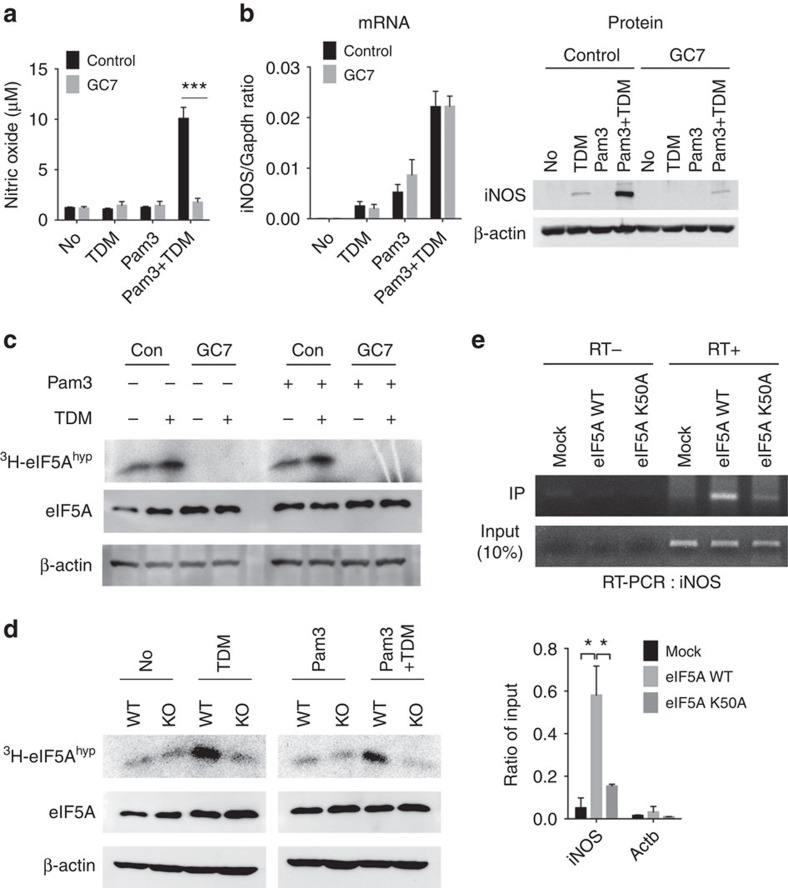
eIF5A hypusination is required for Mincle-mediated iNOS translation.(a,b) WT BMDMs were stimulated with TDM, Pam3 or co-stimulated with Pam3 and TDM in the presence of GC7 for 12 h. (a) Nitric oxide release in culture supernatants. (b) qRT-PCR (left) and immunoblot (right) analysis of iNOS mRNA or protein expression. (c) Fluorographic analysis of hypusinated eIF5A from WT BMDMs treated with Pam3, TDM or co-treated with Pam3 and TDM in the presence of control (con) or GC7. (d) Fluorographic analysis of hypusinated eIF5A from WT and Mincle−/− (KO) BMDMs treated with Pam3, TDM or co-treated with Pam3 and TDM. (e) RIP analysis of iNOS and Actb mRNAs from NIH-3T3 cells co-transfected with expression vector for Flag alone (Flag-Mock) or Flag-tagged eFI5A WT or K50A mutant, plus an iNOS mRNA expression vector. Agarose gel electrophoresis (top) and qRT-PCR analysis (bottom) for the indicated genes. Data are expressed as per cent recovery relative to input RNA. *P<0.05, ***P<0.001 (Student's t-test). Data are representative of three (a,b,e) or two (c,d) independent experiments (a,b,e: mean and s.d.).